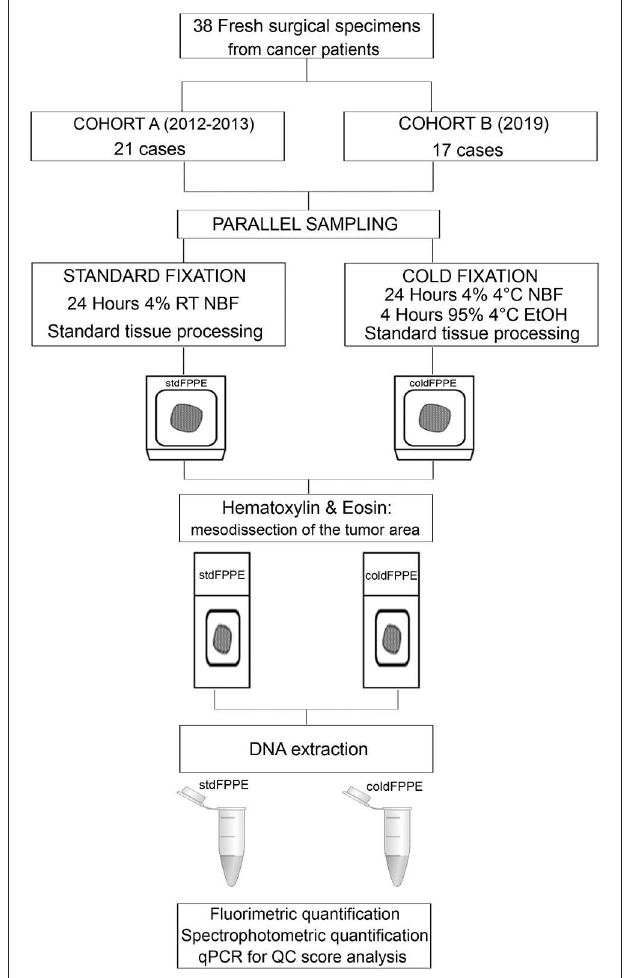
FIGURE 1 | Design of the study. The full cohort comprised 38 cancer specimens that were collected and sampled in parallel to allow standard fixation (i.e., at room temperature) and cold formalin fixation (i.e., at 4 ◦ C). Following processing and tissue sectioning the H&E slides were reviewed to identify the tumor area that was mesodissected for DNA extraction. Two independent cohorts were prospectively collected: Cohort A, whose sampled were collected 6 years prior to the study and DNA extraction performed at present time; Cohort B, whose samples were collected at time of the present study with contextual DNA extraction. For 14 samples from Cohort B, i.e., corresponding to those samples for which at least 6 months elapsed from collection, two DNA extractions were performed: at baseline (at time of collection/fixation) and after 6 months of storage/archival. On the total 90 DNA samples we performed fluorometric and spectrophotometric quantifications and we ran a qPCR with the DEPArray TM FFPE QC Kit. RT, room temperature; NBF, neutral buffered formalin; EtOH,